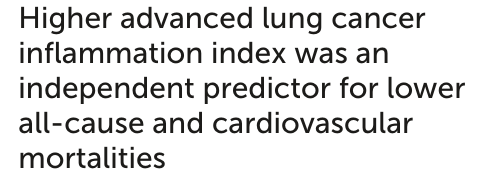
addition, patients in the high-ALI group had higher values of BMI, Alb, hemoglobin, sodium, GNRI, LVEF, and better NYHA class, while they had lower values of white blood cell (WBC), NLR, aspartate aminotransferase (AST), creatinine, uric acid, NT-proBNP, and less proportion of combined